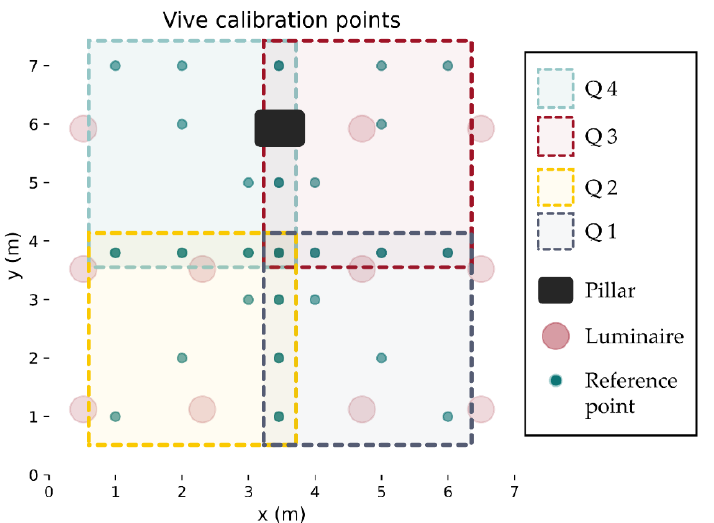
Figure 13. Calibration points used for deriving the transformations. Twenty-six reference points were carefully mapped out using a laser level and tape measure in such a way that each quadrant would have 10 reference calibration points, sharing four with each neighbor. This reduced the overall number of calibration points required.